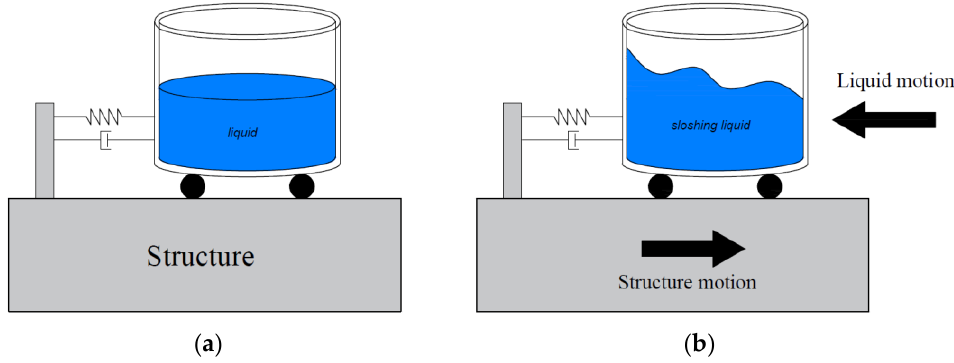
Figure 1. The structure + TLD model ( a ) static position of the system and ( b ) sloshing motion that occurs in the TLD.